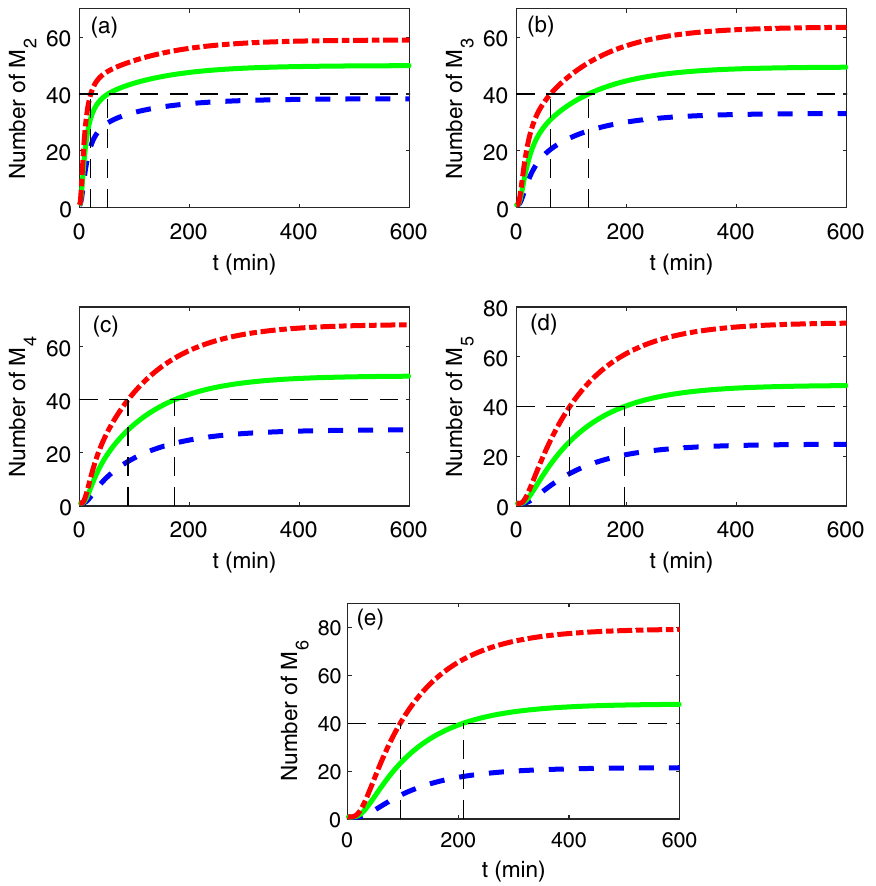
Figure 3. The time evolution of the number of different tapes of oligomers obtained by the moment closure method for different initial number of monomers x 1 ( 0 ) : x 1 ( 0 ) = 1000 (blue broken line), x 1 ( 0 ) = 1500 (green solid line) and x 1 ( 0 ) = 2000 (red dotted dash line). The horizontal dotted line represents a given level of the number of oligomers, while the vertical dotted line represents the time required to reach the given level. The other parameters are same as Fig. 2. The results by SSA are based on 10,000